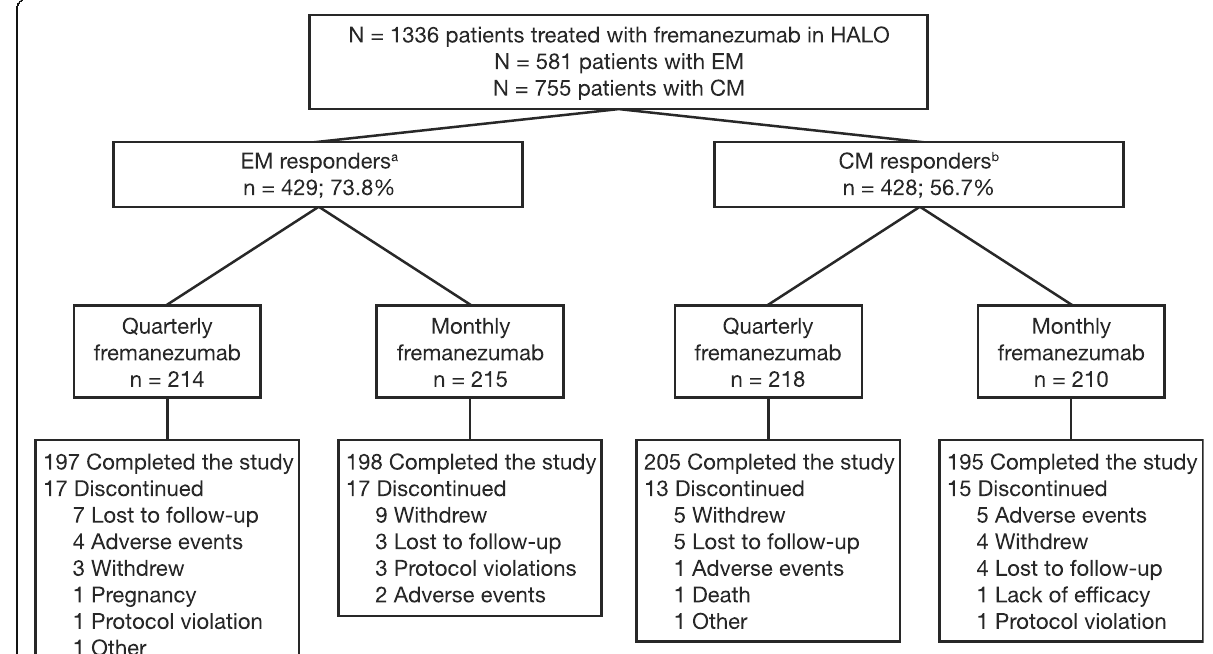
Fig. 1 Patient disposition. CM, chronic migraine; EM, episodic migraine; MAMD, monthly average migraine days. a For participants with EM, response was defined as a reduction of ≥ 2 MAMD. b For participants with CM, response was defined as a reduction of ≥ 4